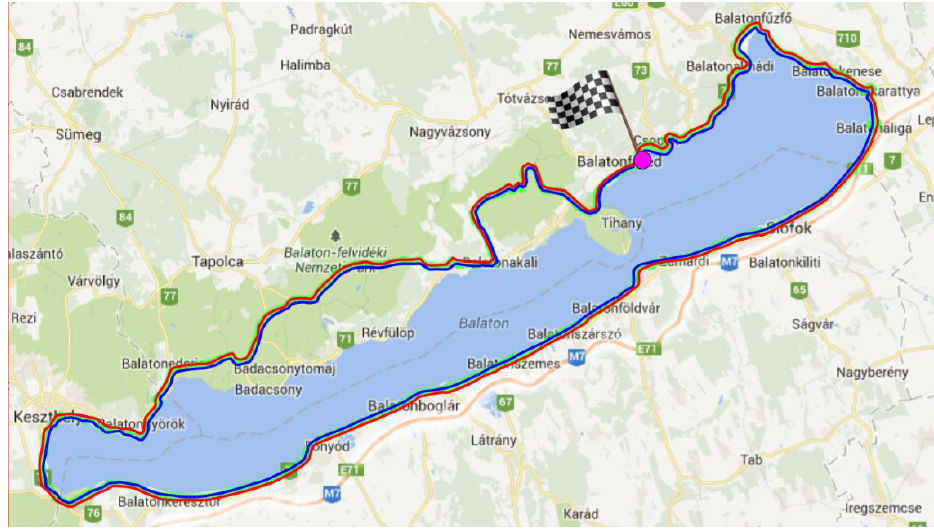
Figure 1. The website used to monitor performance in the project.